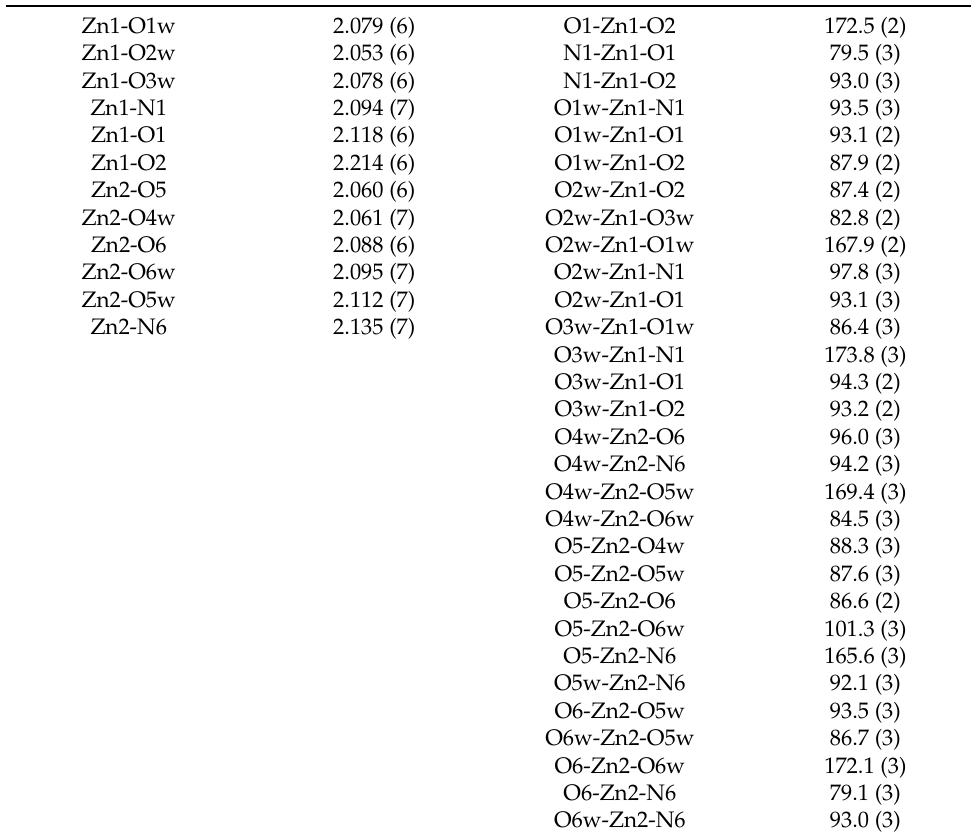
Table 6. Selected bond distances and angles [Å, ◦ ] for 5 .